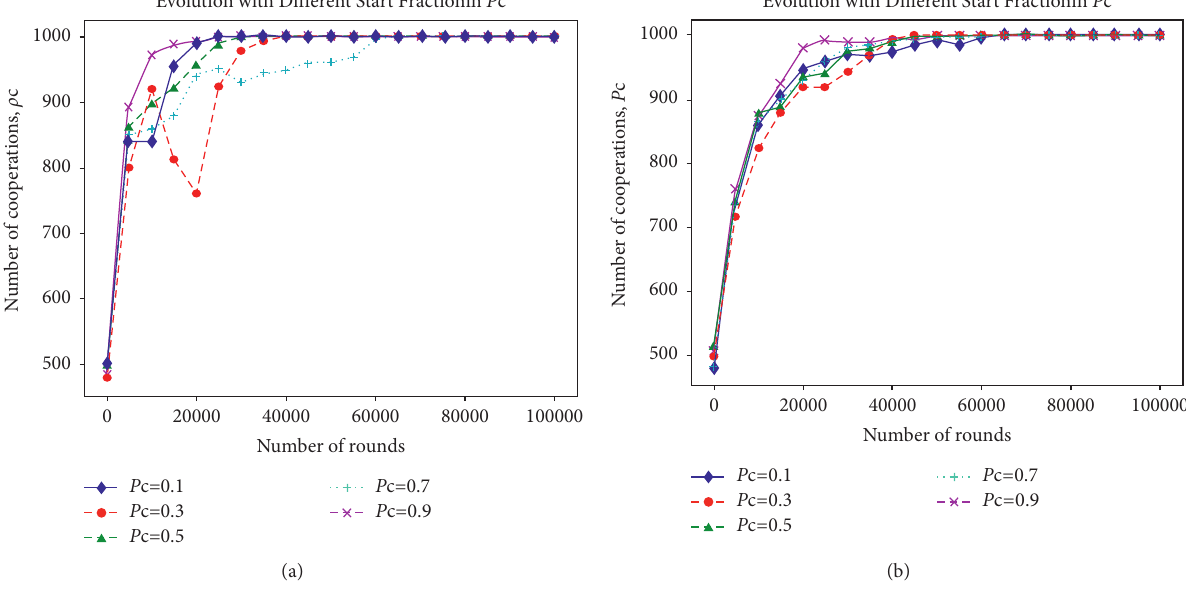
Figure 4: Cooperative evolution in two types of complex networks. (a) Cooperative evolution in BA scale-free network. (b) Cooperative evolution in WS small-world